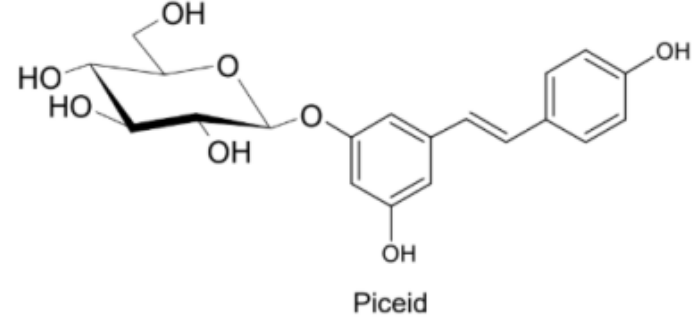
Figure 3. Trans Figure 3. Trans -resveratrol-3-O-D-glycoside.